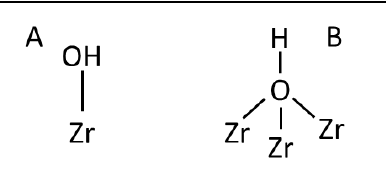
  Figure 1. XRD patterns for ZrO 2 and CuO/ZrO 2 : m-ZrO 2 (*), t-ZrO 2 (●), CuO ( ♦